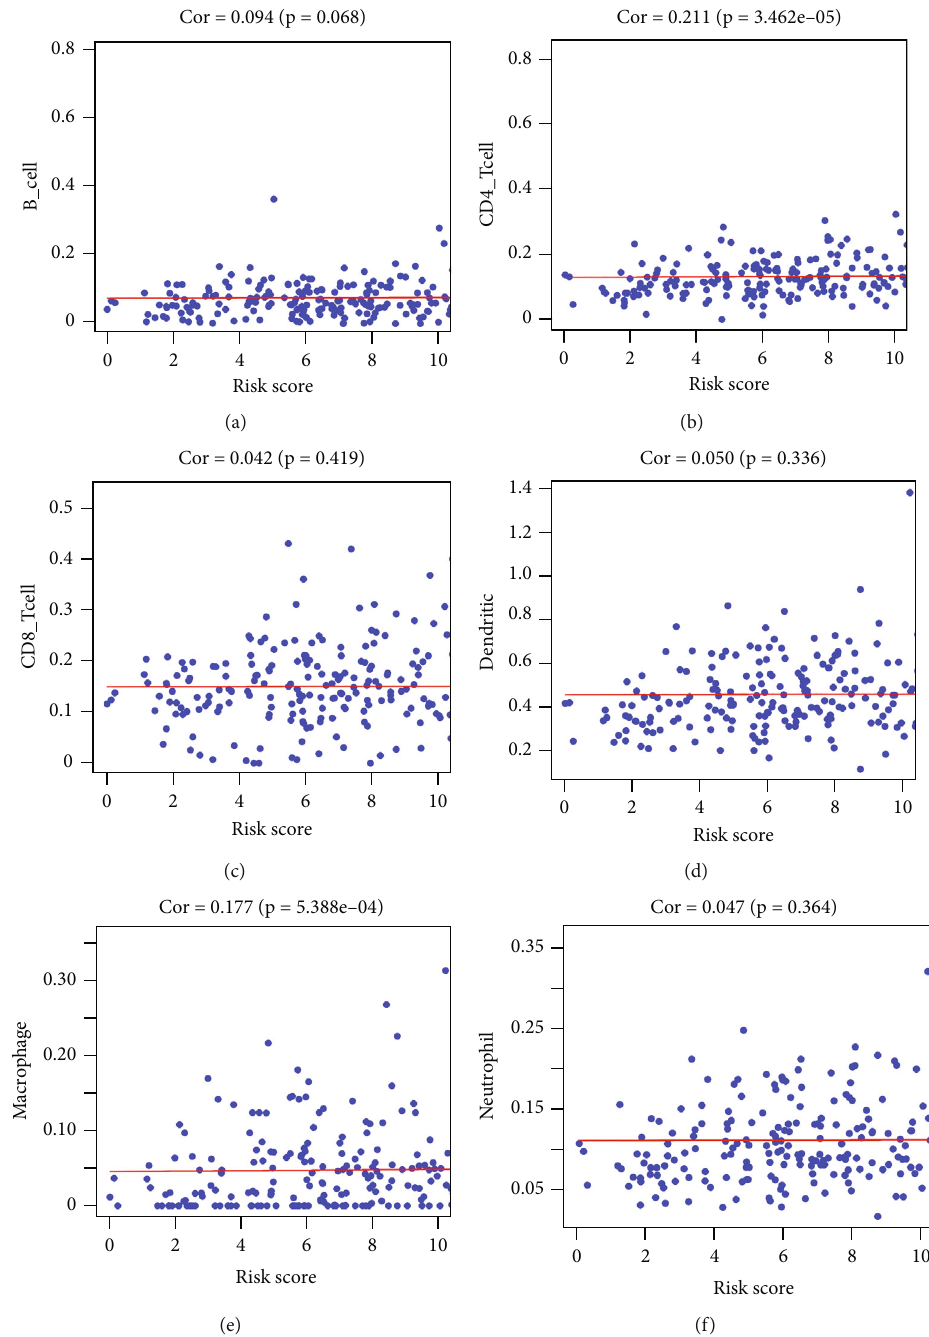
Figure 8: Relationships between risk score and in fi ltration abundances of six immune cell types. (a) B cells, (b) CD4 T cells, (c) CD8 T cells, (d) dendritic cells, (e) macrophages, and (f) neutrophils. The results showed that CD4 T cell was signi fi cantly positively correlated with risk score ( p < 0 : 05 ). B cell, CD8 T cell, dendritic cell, macrophage, and neutrophil are not correlated with risk score ( p > 0 : 05